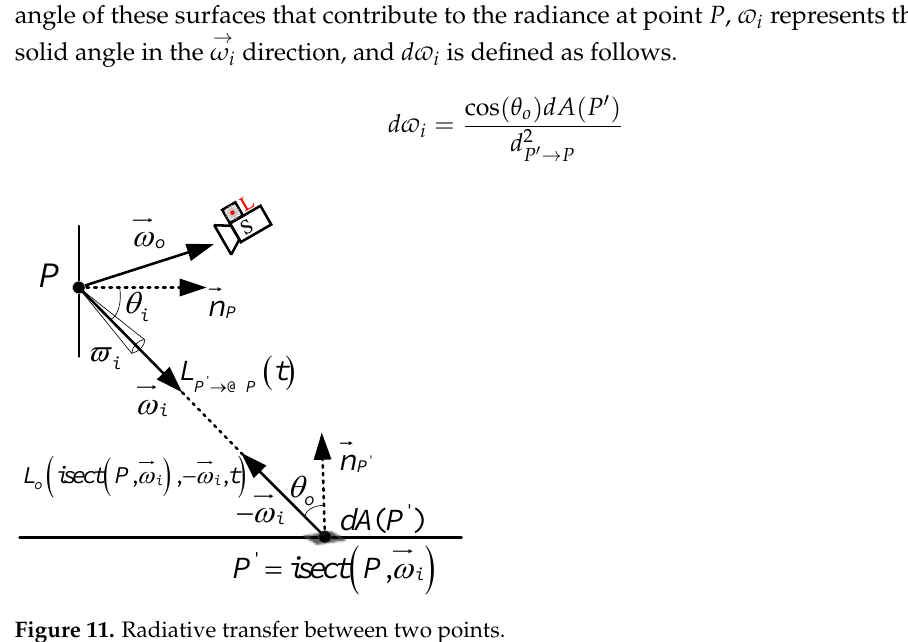
 d P L where L P and the point , and P L → is → is the distance between the light source P L the included angle between the vector P L v → of pointing to and the normal vector P . P n of the surface at point The direct illumination radiance generated by the infrared light source P S → P along the direction of at point is: Figure 10. The schematic diagram of direct lighting. Figure 10. The schematic diagram of direct lighting. In addition to the direct illumination of light sources, the light signal reflected by other surfaces will also affect the radiance at point P , as shown in Figure 11. We call this part f where L P S → → represents the BRDF of the surface. For the irradiance of ( t ) , which is defined as follows. indirect illumination radiance denoted by L indirect @ P → S ambient light sources ' L such as the Sun, the Earth, and the Moon, as shown in Formulas (12) – (14), the cosine component of where L P (cid:48) → @ P ( t ) represents the radiance generated by P (cid:48) at point P , Ω represents the solid angle of these surfaces that contribute to the radiance at point P , (cid:118) i represents the micro → ω i direction, and d (cid:118) i is defined as follows. solid angle in the